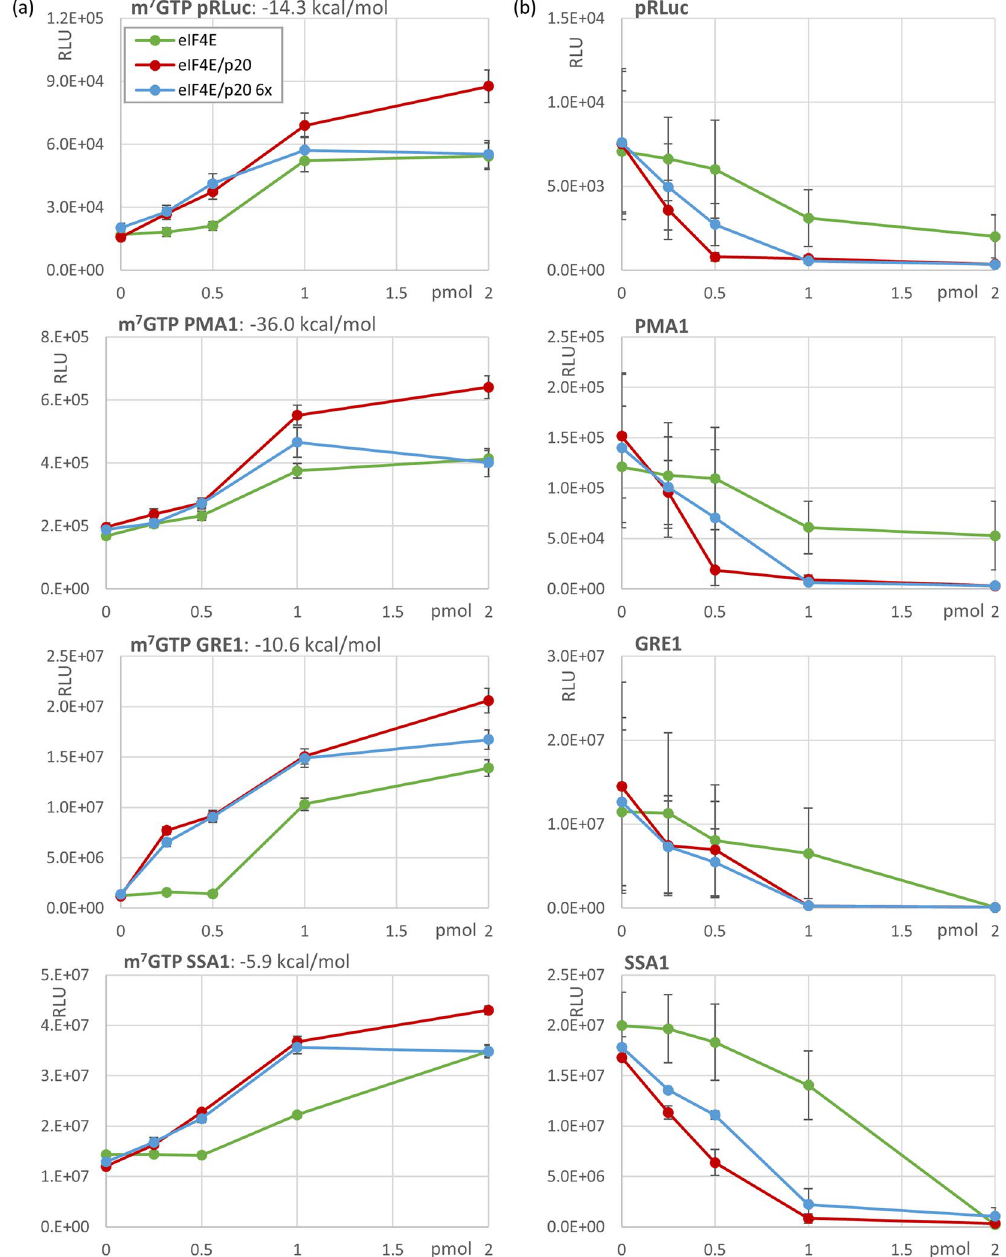
Figure 3. In vitro translation assays performed with 10 ng/assay capped or uncapped “average synthetic” RLuc, PMA1, GRE1 or SSA1 5 ′ UTRs fused to Renilla Luciferase ORF and increasing amounts of His6x-eIF4E alone (green), eIF4E/His6x-p20 complex (red) or eIF4E/His6x-p20 6 × mutant complex (blue). Data presented are the mean luminescence activity in relative light units (RLU ± s.e.m.; n = 3). The calculated free energy (kcal/ mol) of each 5 ′ UTR is shown above each panel in ( a ). ( a ) In vitro translation assays of capped RNAs. ( b ) In vitro translation assays of uncapped